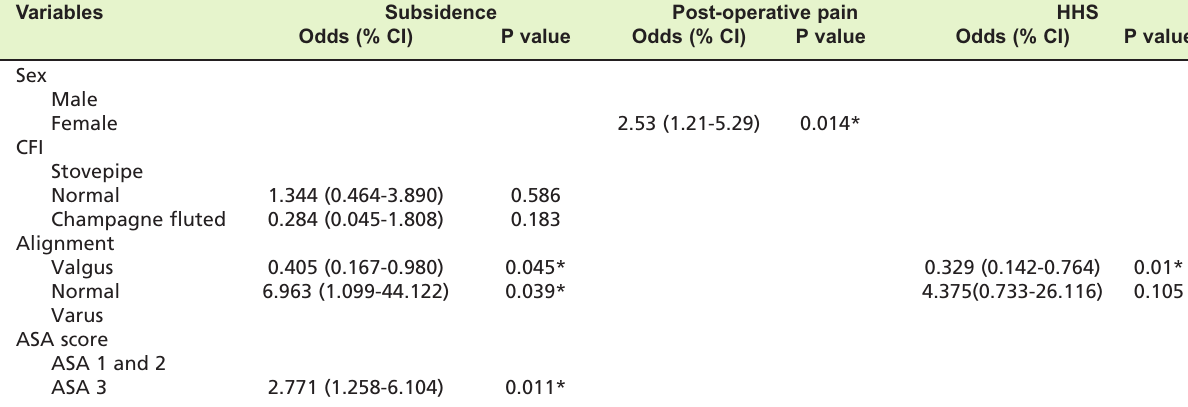
Multivariate analysis results Table III: